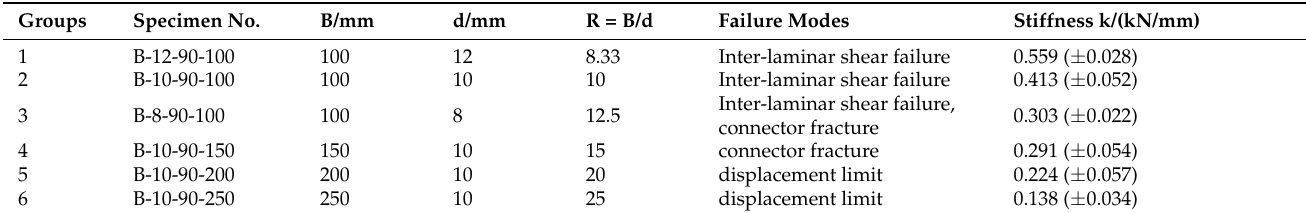
Table 4. Failure modes and stiffness of specimen with different span